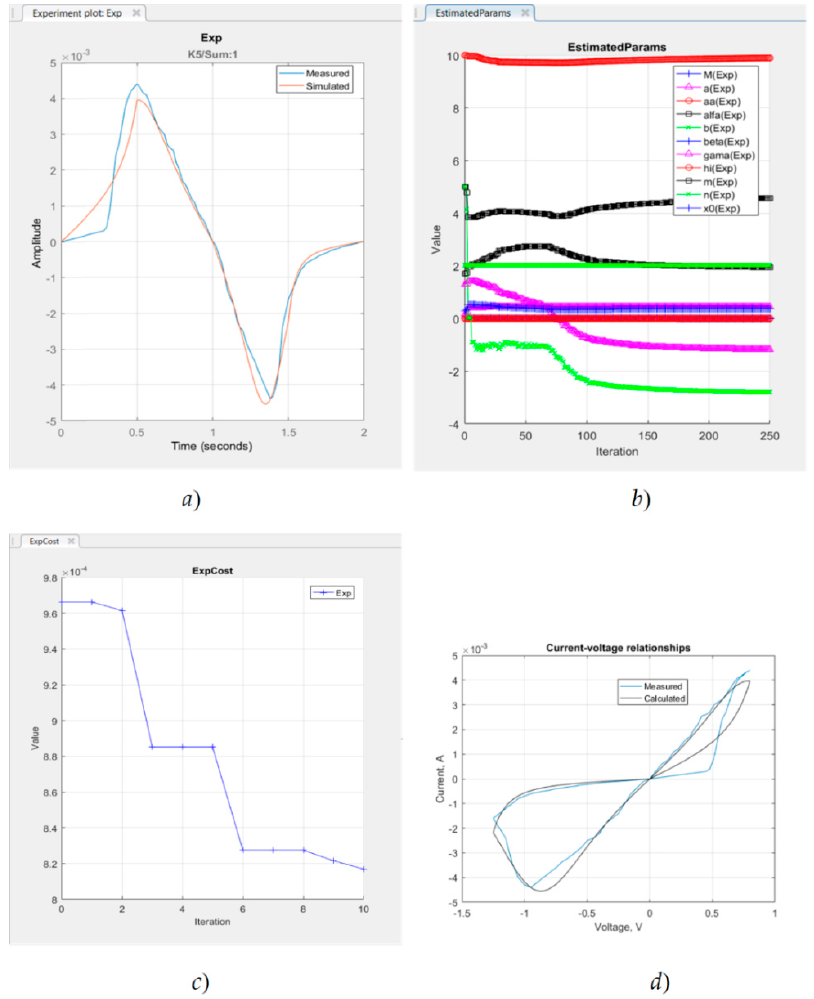
Figure 2. ( a ) The simulated and experimental current–voltage relationships of a titanium-dioxide memristor after tuning the model A 5 ; ( b ) The change of the memristor model’s parameters during the estimation procedure; ( c ) Diagram of the decreasing of the cost function during the estimation of the model’s parameters; ( d ) The corresponding experimental and simulated current–voltage relationships of the considered memristor element.